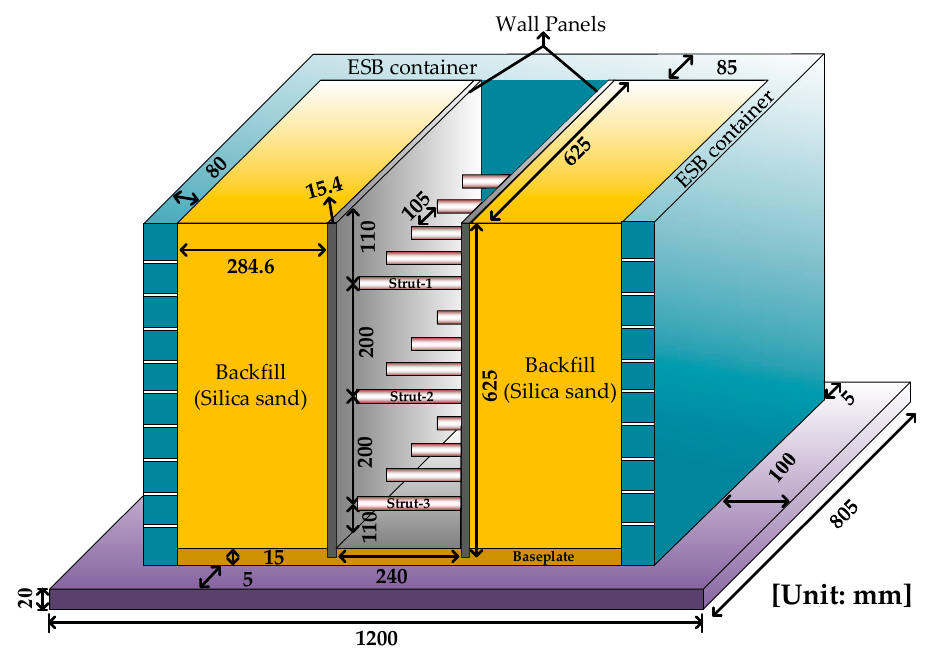
Figure 2. Geometry of strutted excavation.